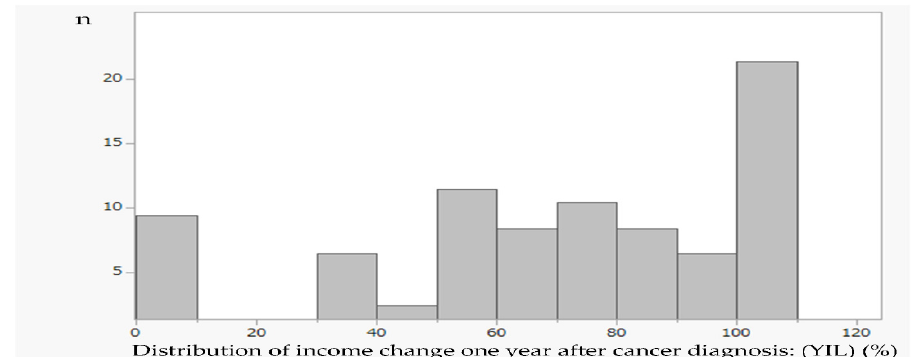
Figure 1. Distribution of income change one year after cancer diagnosis. Year-on-year income level (YIL) (%): the percentage change between just before and one year after their cancer diagnosis, n = 72. Mean (SD) = 66 (32)%, median = 70%. SD: standard deviation. Multivariable analysis (ANCOVA) was performed for the five items that showed sig- nificant differences: age of onset, stage, employment status at diagnosis, support from the vealed that cancer stage ( p = 0.016), employment status at diagnosis ( p = 0.006), and con- tinued employment at the same workplace ( p = 0.001) were associated with YIL.